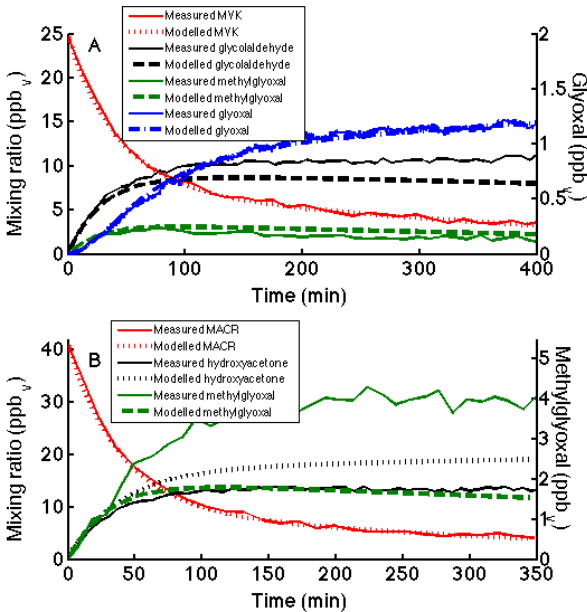
Fig. 4. (A) Modified MCM v.3.2 Model and measurement com- parison for high-NO x MVK oxidation (Exp.8). The left axis corre- sponds to all compounds except glyoxal. The glycolaldehyde to gly- oxal yield was set to 0.29 for this model run. (B) MCM v. 3.2 Model and measurement comparison for high-NO x MACR oxidation (Exp.